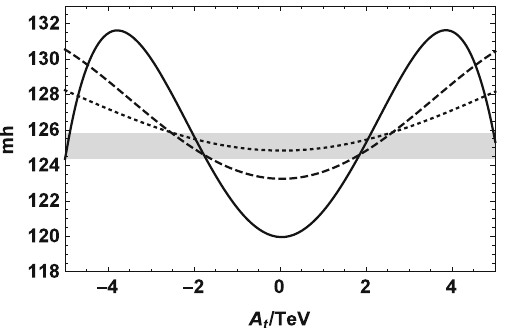
Fig. 7 Taking tan β = 20, we plot the SM-like Higgs mass m h versus A t for m ˜ t = 1 . 5TeV (solid line), m ˜ t = 2 . 5TeV (dashed line) and m ˜ t = 3 . 5TeV (dotted line), where the gray area denotes the experimental 3 σ